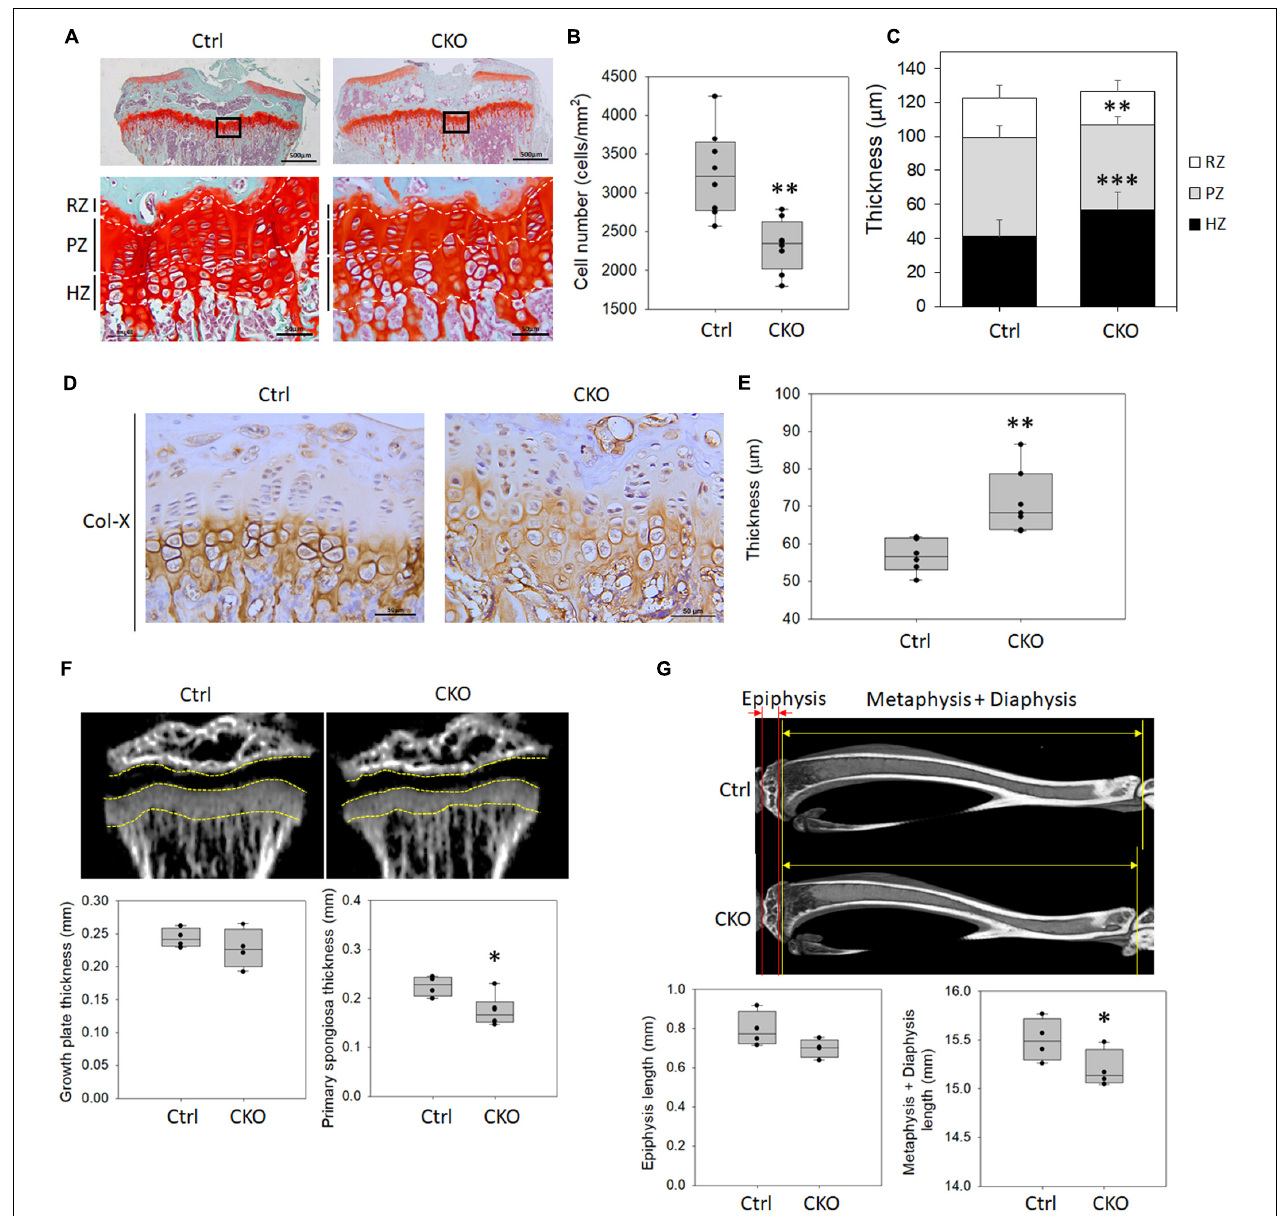
FIGURE 4 | Changes of growth plate development in chondrocyte-specific GPER-1 knockout (CKO) mice. (A) Tibial growth plates of 8-week-old female mice were stained with Safranin O/Fast Green staining. Representative micrographs of growth plates at low (scale bars, 500 µ m) and high (scale bars, 50 µ m) magnification. (B) Cell numbers were measured in CKO mice. (C) Thicknesses of resting zone, proliferation zone, and hyperopic zone were analyzed. (D) Hypertrophic zones of growth plates were stained via IHC to detect type X collagen (Col-X) in 8-week-old mice. Scale bars, 50 µ m. (E) Thicknesses of type X collagen-stained hypertrophic zone were quantified. (F) Thicknesses of growth plate and primary spongiosa of 4-week-old mice were measured by µ -CT analysis. (G) Lengths of epiphysis and metaphysis plus diaphysis of 8-week-old mice were measured by µ -CT analysis. Each group, N = 4–8. ∗ P < 0.05, ∗∗ P < 0.01, ∗∗∗ P < 0.001. RZ: resting zone, PZ: proliferative zone, HZ: hypertrophic